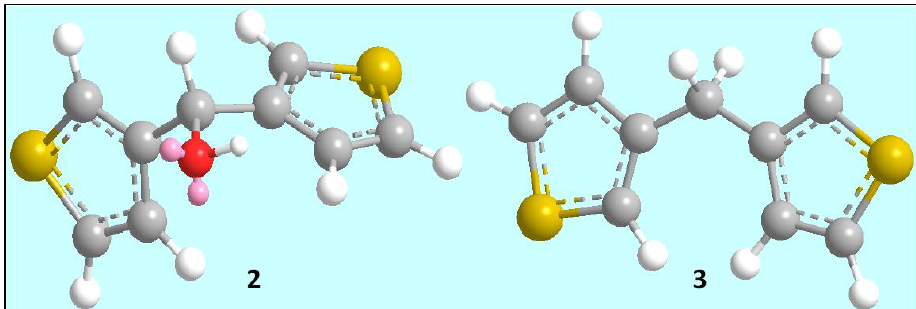
Figure 1. Energy minimized 3D structure of di(3-thienyl)methanol ( 2 ) and di(3-thienyl)methane ( 3 ). Red, yellow, white color ball represents oxygen, sulfur and hydrogen atoms respectively. Pink balls represent lone pairs on the oxygen